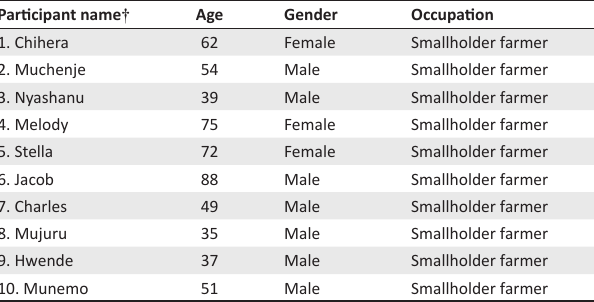
TABLE 2: Focus group discussion participants.